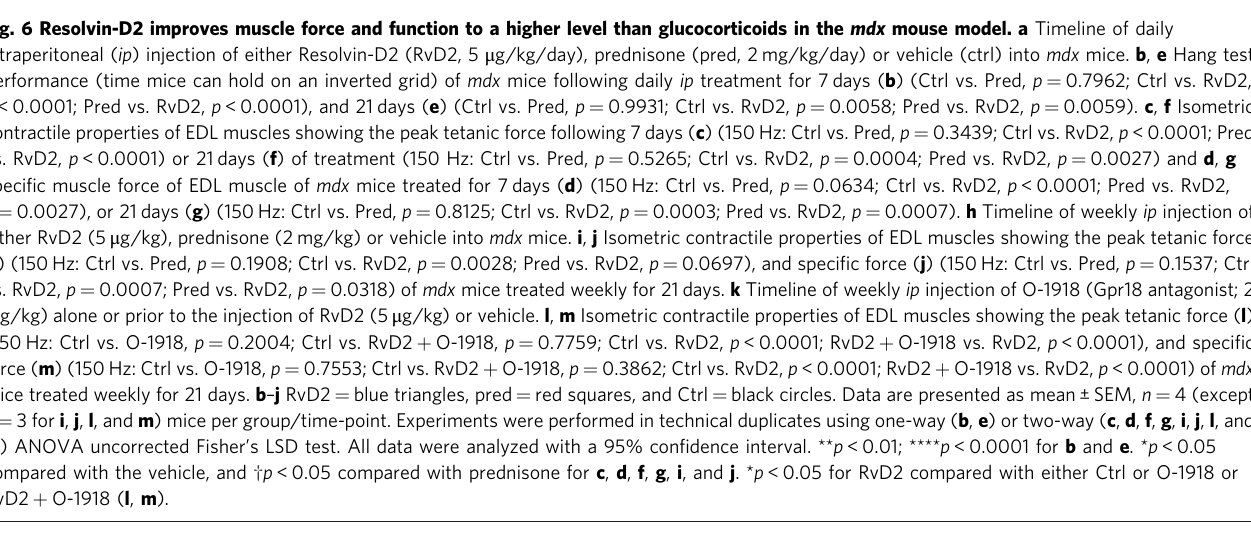
mice treated weekly for 21 days. b – j RvD2 = blue triangles, pred = red squares, and Ctrl = black circles. Data are presented as mean ± SEM, n = 4 (except n = 3 for i , j , l , and m ) mice per group/time-point. Experiments were performed in technical duplicates using one-way ( b , e ) or two-way ( c , d , f , g , i , j , l , and m ) ANOVA uncorrected Fisher ’ s LSD test. All data were analyzed with a 95% con fi dence interval. ** p < 0.01; **** p < 0.0001 for b and e . * p < 0.05 compared with the vehicle, and † p < 0.05 compared with prednisone for c , d , f , g , i , and j . * p < 0.05 for RvD2 compared with either Ctrl or O-1918 or RvD2 + O-1918 ( l , m ).